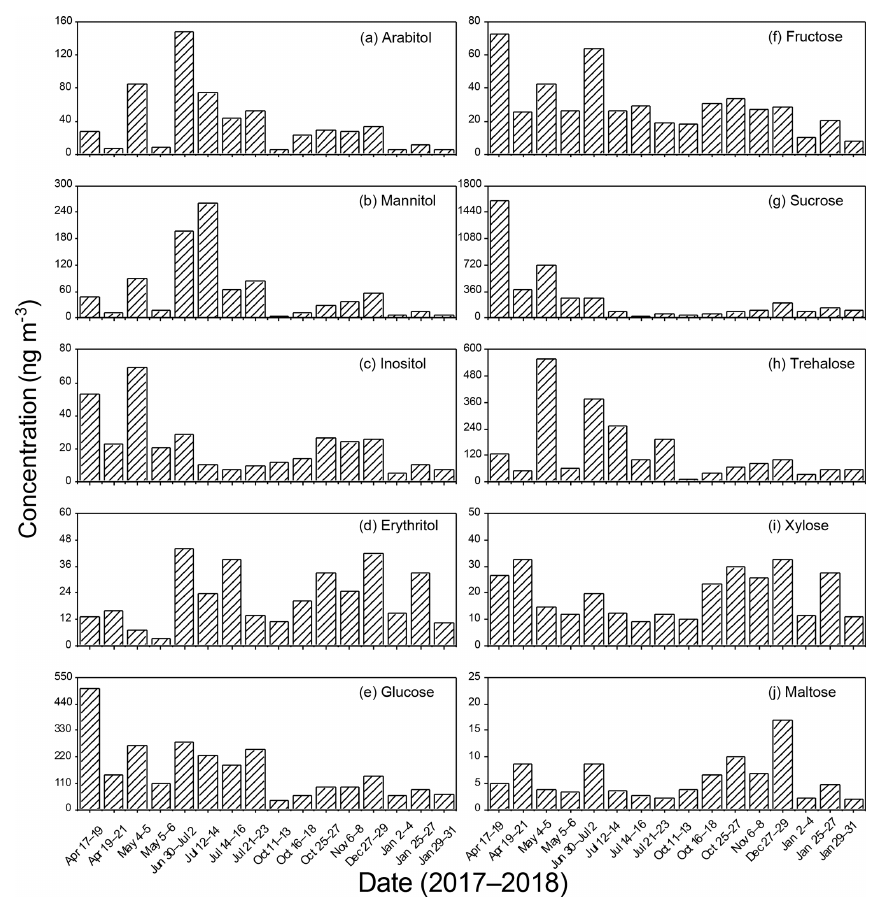
Figure 4. Temporal variations in primary saccharides and sugar alcohols in urban Beijing aerosols from April 2017 to January